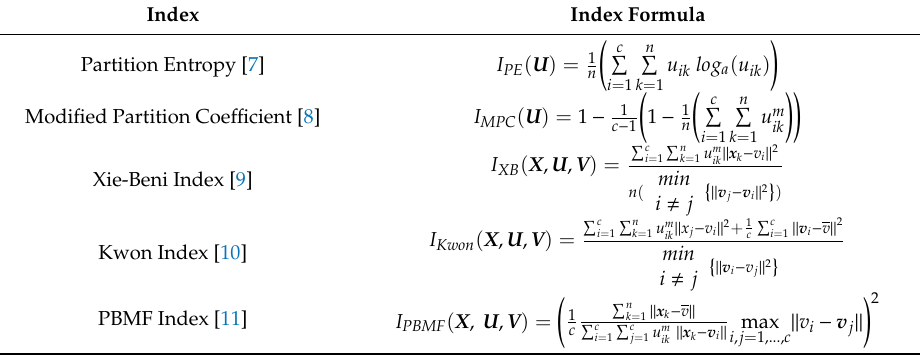
Table 1. Internal validity indices for validation of fuzzy clustering